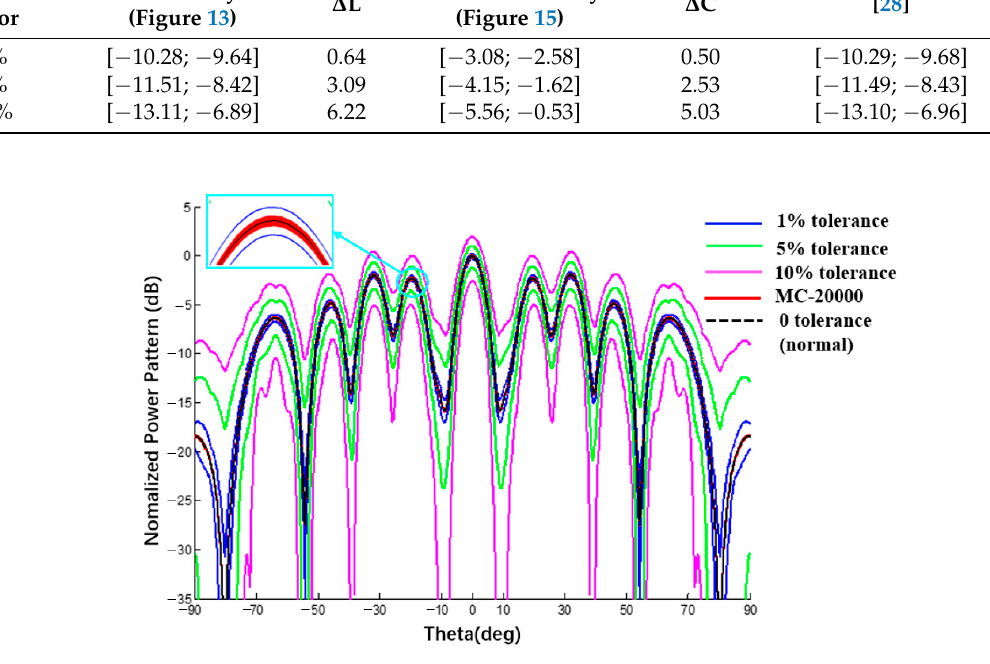
Figure 15. Power pattern under different excitation amplitude tolerances (Plane E, Dolph–Chebyshev excitation, the tolerance of MC method is 1%). Table 3. Numerical results of power pattern in Figures 14 and